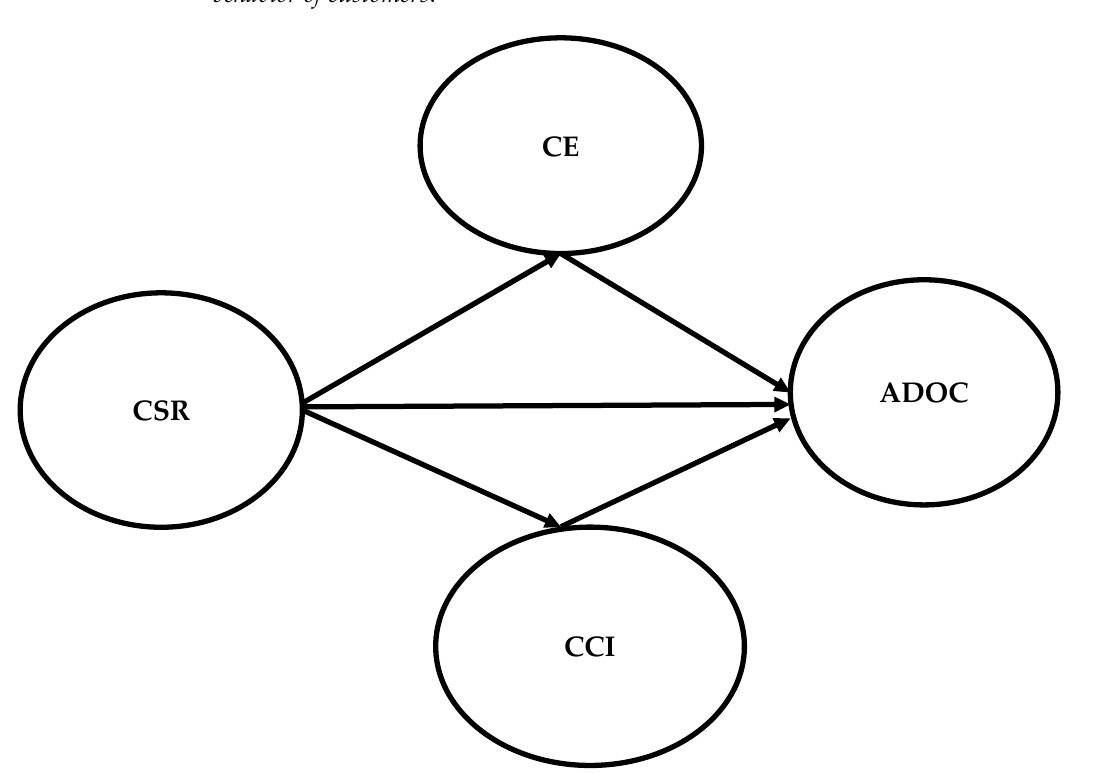
Figure 1. The conceptual model where CSR = corporate social responsibility, CE = customer engagement, CCI = customer company identification, and ADOC = advocacy behavior.